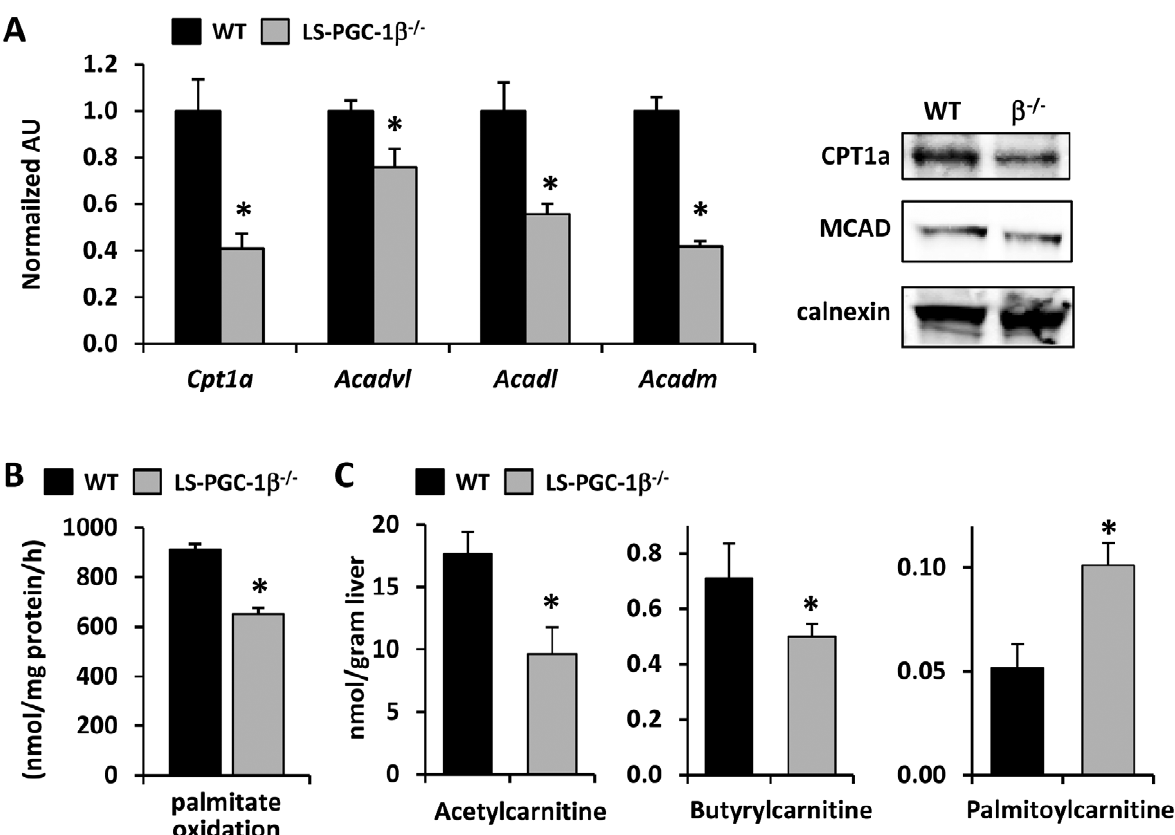
Figure 2. LS-PGC-1 b 2 / 2 mice have decreased FAO gene expression and decreased rates of palmitate oxidation. [ A ] The graph shows the expression of PGC-1 target gene mRNA involved in FAO in the liver of 6 week old WT (fl/fl) or littermate LS-PGC-1 b 2 / 2 mice (n=5). *P , 0.05 vs. WT mice. Representative Western blotting analysis of enzymes involved in fatty acid oxidation. [ B ] Rates of palmitate oxidation in hepatocytes isolated from LS-PGC-1 b 2 / 2 or littermate control mice. *P , 0.05 vs. WT mice. [ C ] The graph represents LCMS-based quantification of acyl-carnitine species in the liver of 6 week old female WT (fl/fl) or littermate LS-PGC-1 b 2 / 2 mice. *P , 0.05 vs. WT mice.